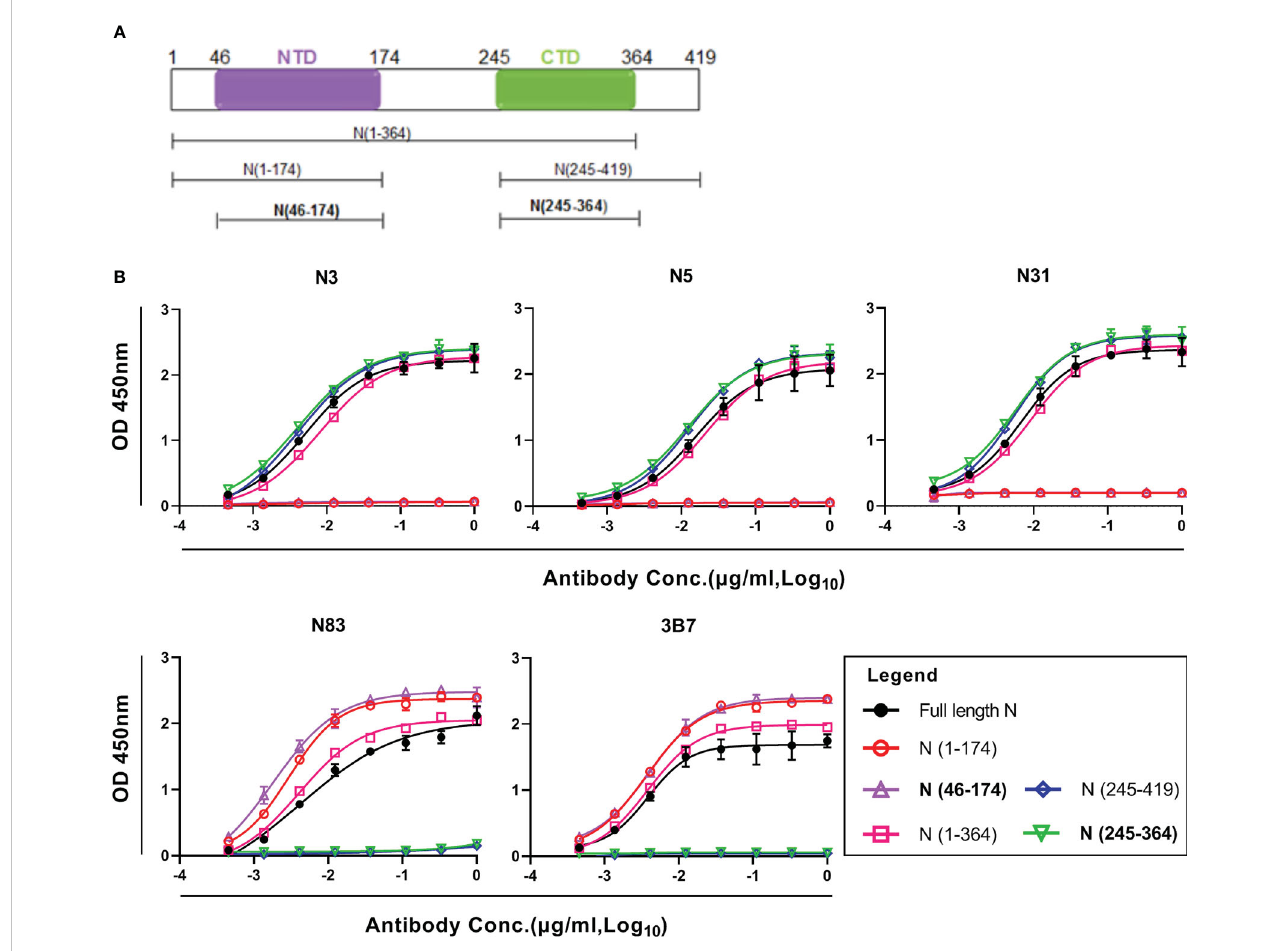
FIGURE 2 Epitope mapping of patient – derived mAbs to SARS – CoV – 2 N protein. (A) Schematic of the SARS – CoV – 2 N protein structure and domains. (B) ELISA results showing the binding curves of 5 hmAbs to full – length and fragments of SARS – CoV – 2 N proteins. All samples were detected in duplicate. NTD, N – terminal domain; CTD, C – terminal